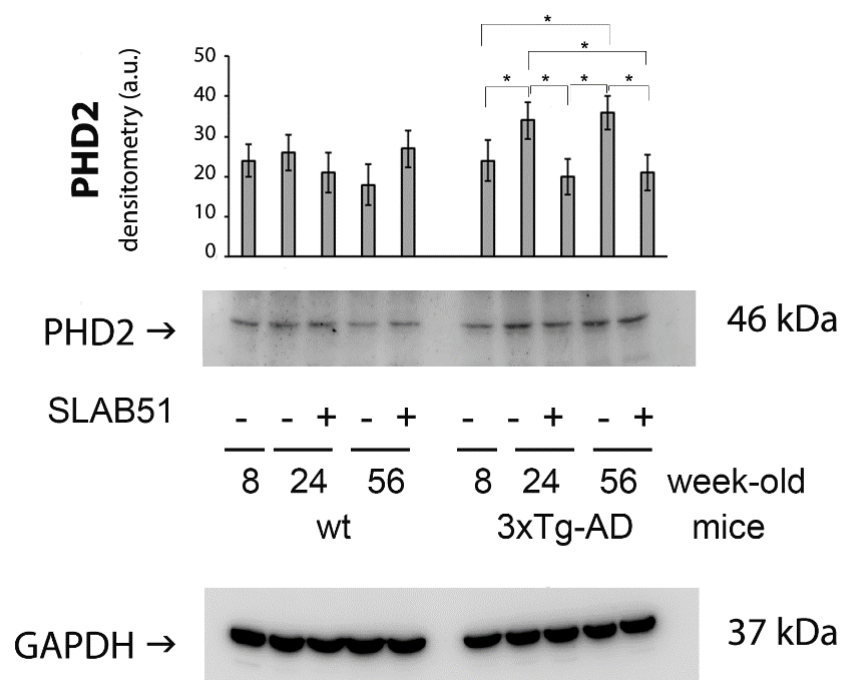
Figure 3. Decreased cerebral expression of PDH2 in treated AD mice. PHD2 expression levels normalized by GAPDH, measured in brain homogenates of SLAB51-treated and SLAB51-untreated wt (left) and AD (right) mice. The densitometric analyses obtained from three separate blots and representative immunoblots are shown. Equal protein loading was verified by using an anti-GAPDH antibody. The detection was performed with an ECL Western blotting analysis system. Statistical significance compared to untreated 8-week-old mice and age-matched mice is indicated with asterisks (* p < 0.05).